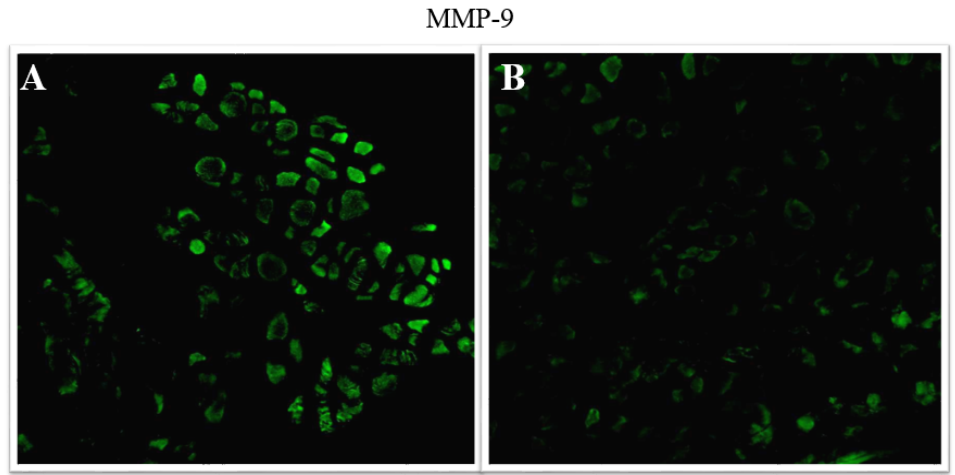
Figure 4. Immunofluorescence reactions anti MMP-9 (green fluorescence) in contralateral ( A ) and ipsilateral ( B ) masseter muscle of patients affected by unilateral posterior crossbite. The fluorescence pattern of MMP-9 is higher in the contralateral masseter muscle if compared to the fluorescence pattern in the ipsilateral muscle. p -value < 0.05.